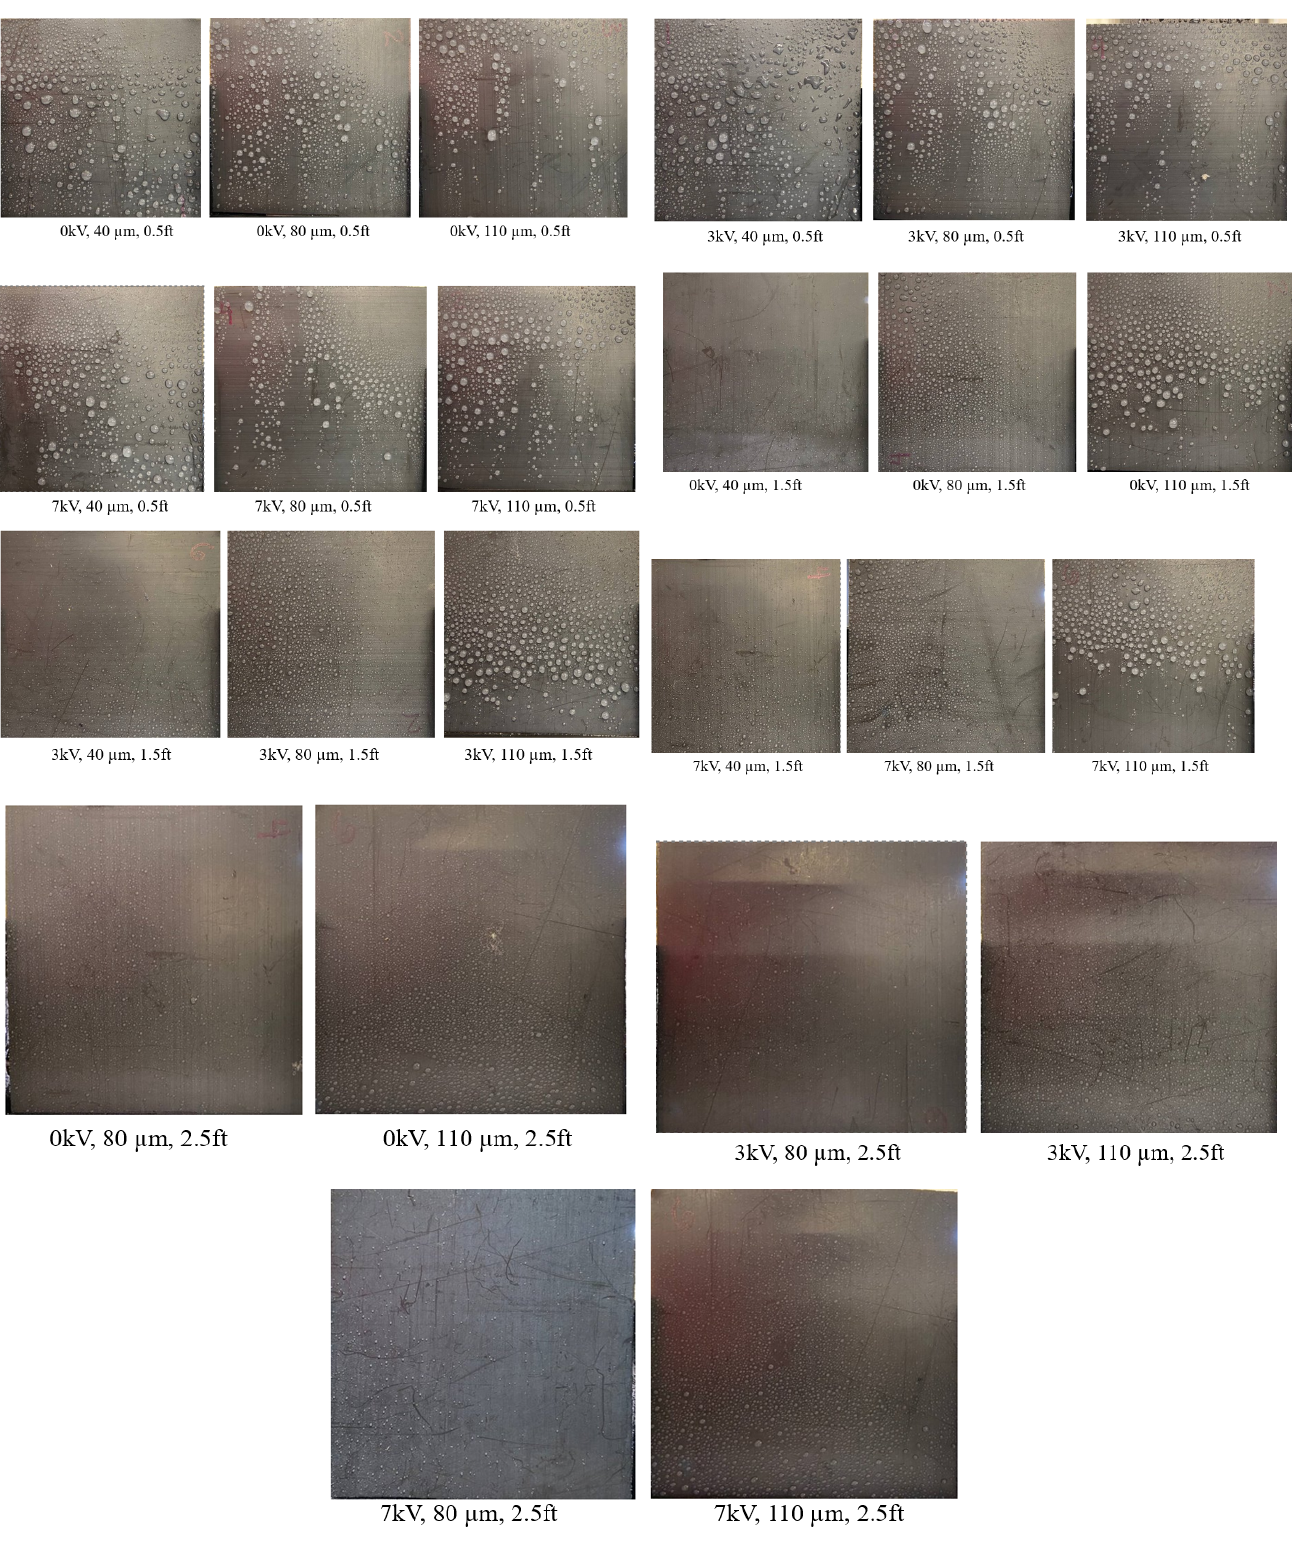
Figure A21. Teflon: qualitative images of electrostatic deposition under various system